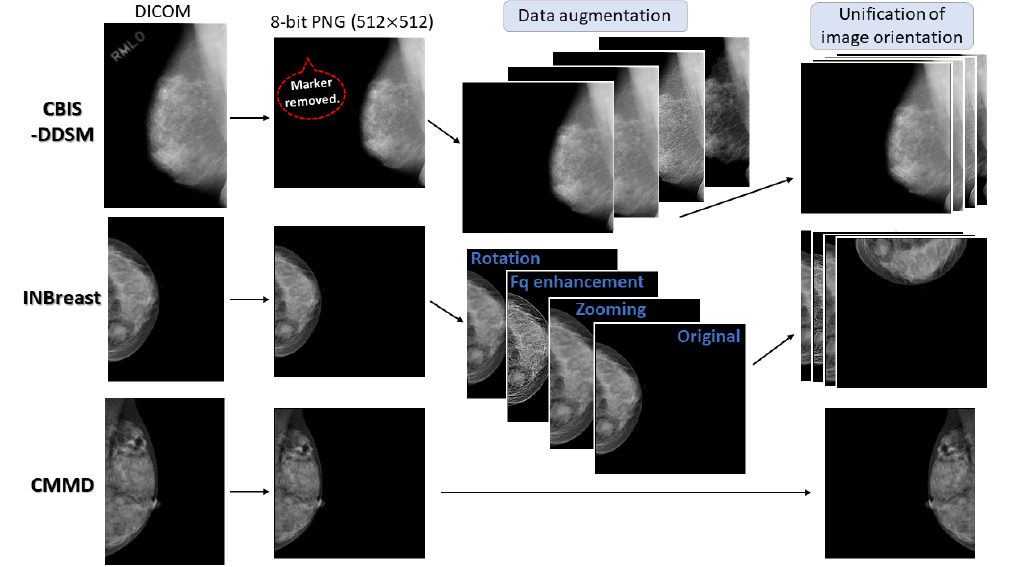
Figure 5. Pre-processing flow for training. Mammograms from each database were converted into 8-bit PNG images with 512 × 512 resolution. Data augmentation was applied to quadruple the number of training data pairs from CBIS-DDSM and INBreast. The orientations of all CC images were unified to be similar to frontal face photographs. Left MLO images were horizontally flipped to have the same orientation as right MLO